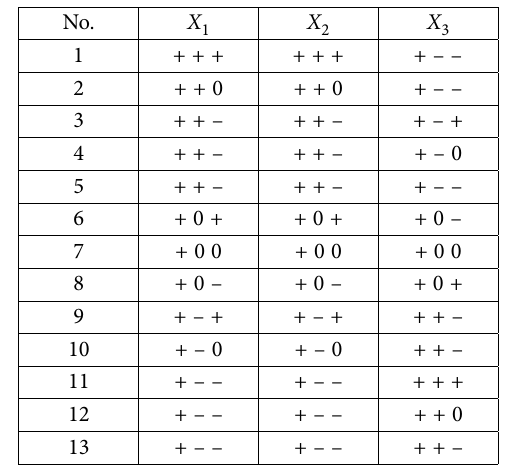
Table 3. Scenarios (source: Vicha & Dohnal,